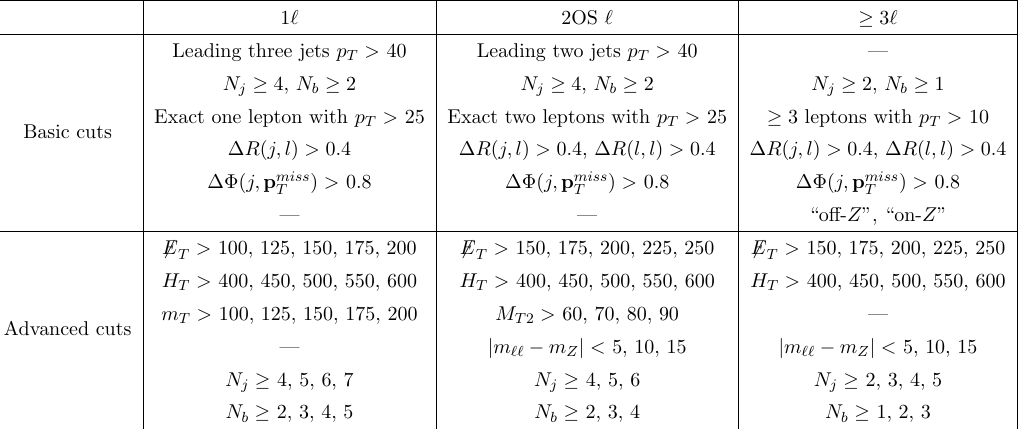
Table 4 . The basic cuts and the advanced cuts for the three primary signal regions of 1 ‘ , 2 OS ‘ and 3 ‘ . All mass units are in (cid:21)